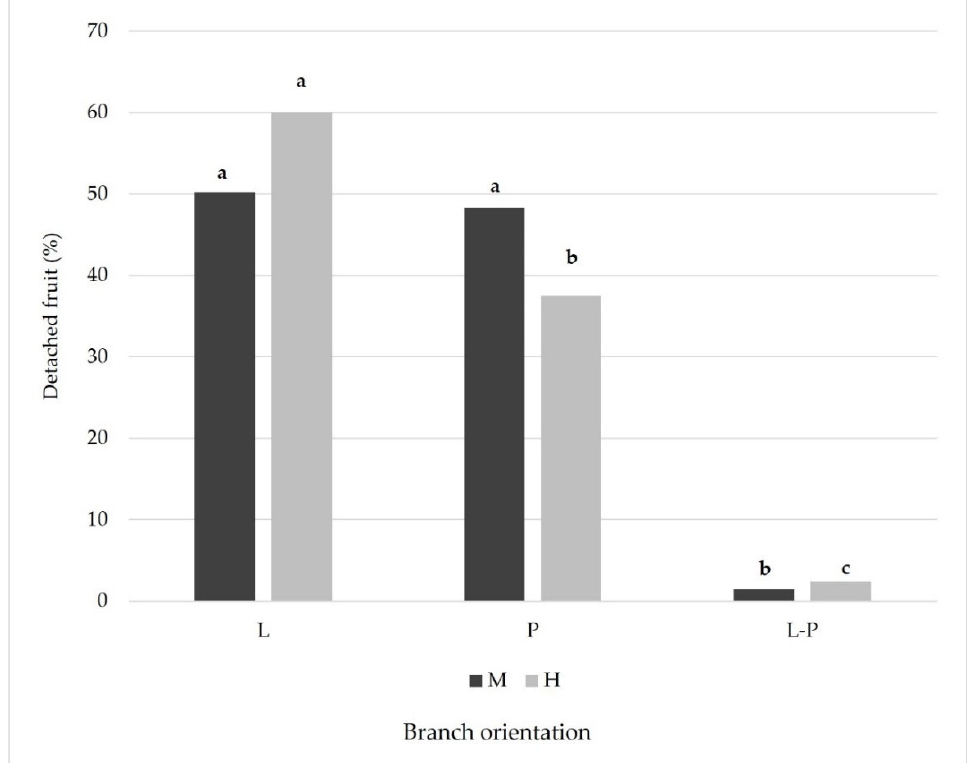
Figure 3. Mechanical (M) and manually (H) detached fruits, in relation to branch orientation: longitudinal (L) and perpendicular (P). Means followed by the same letter do not differ significantly at p ≤ 0.05 according to Duncan’s test. Statistical comparisons were carried out within each thinning technique.